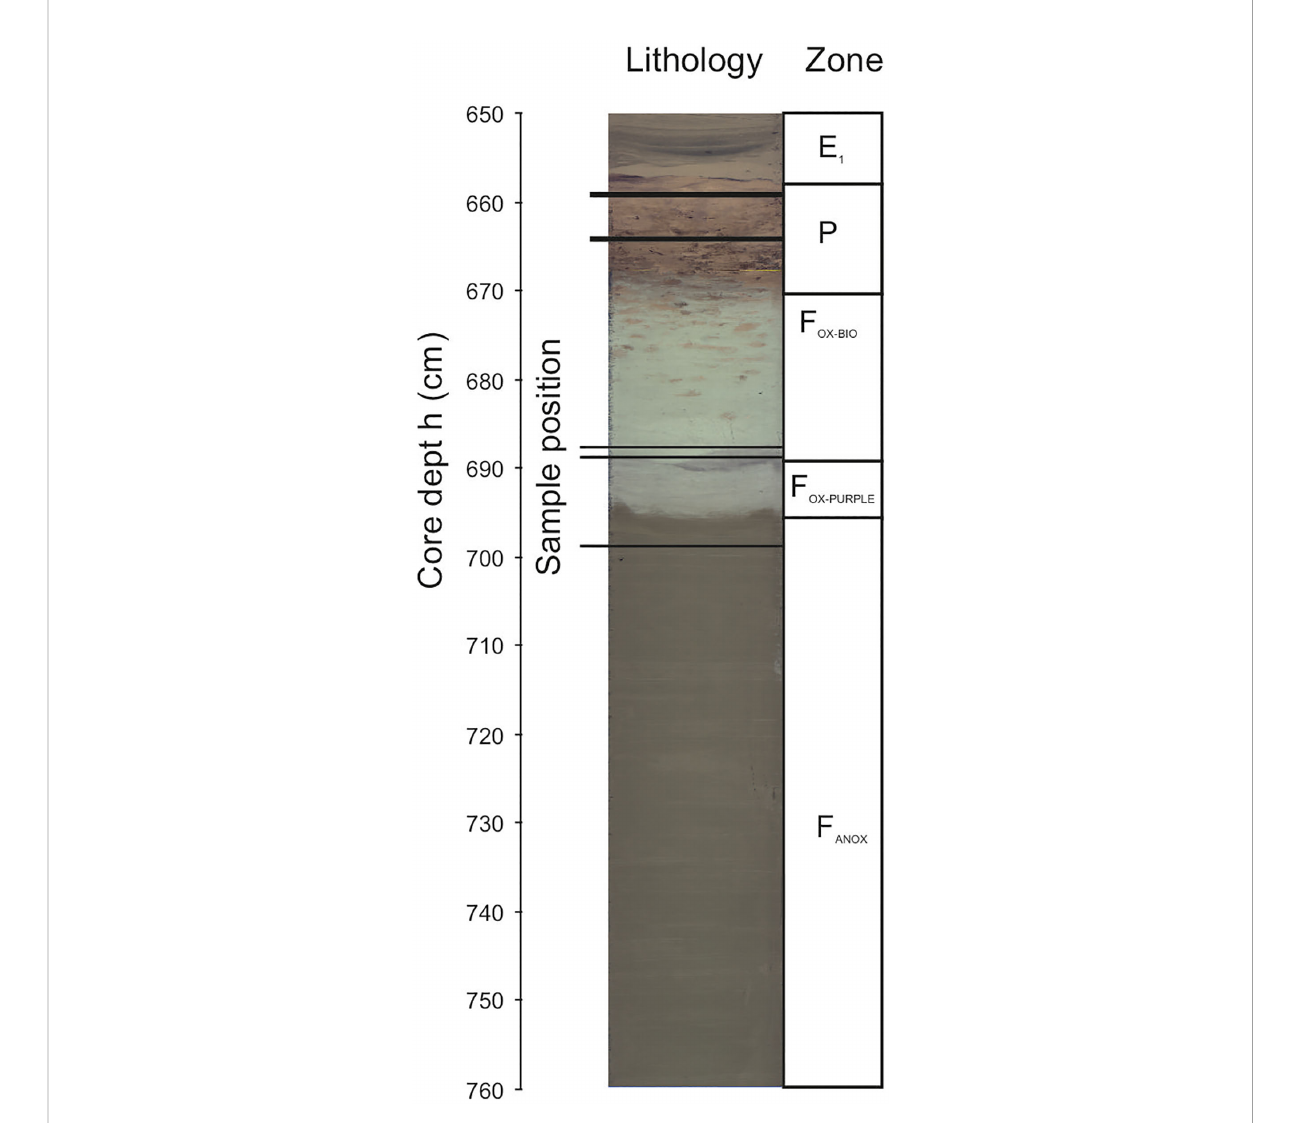
FIGURE 2 Compiled line scan and schematic drawing of core GeoB 20305-7 sections 2 and 3 depicting sample positions as well as the different redox